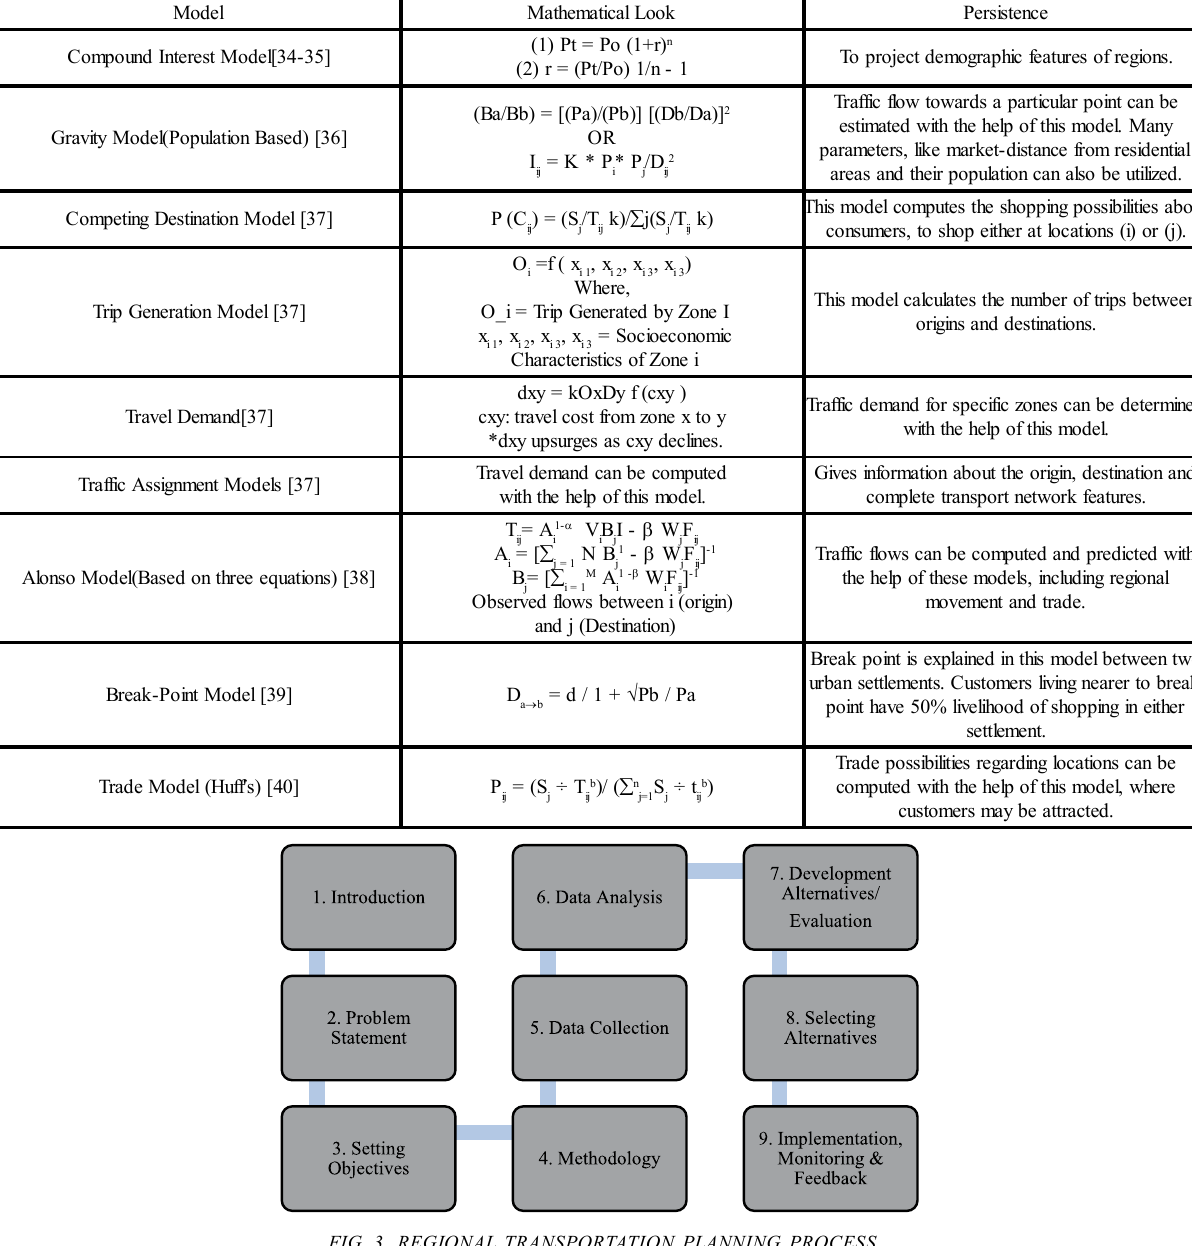
FIG. 3. REGIONAL TRANSPORTATION PLANNING